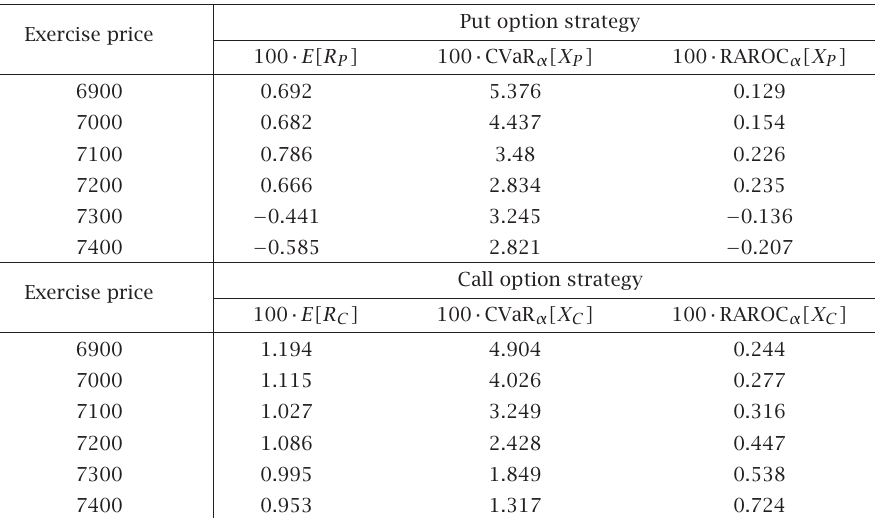
Table 3.2 . CVaR for portfolio insurance of SMI, α ≥ 0 .